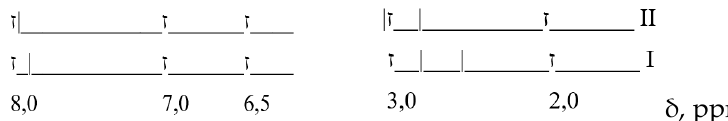
Figure 1. Graphic presentation of PMR spectra of dimethylformamide and the complex ‘Dimethylformamide-cobalt chloride’. I—DMF; II—DMF with CoCl 2 .